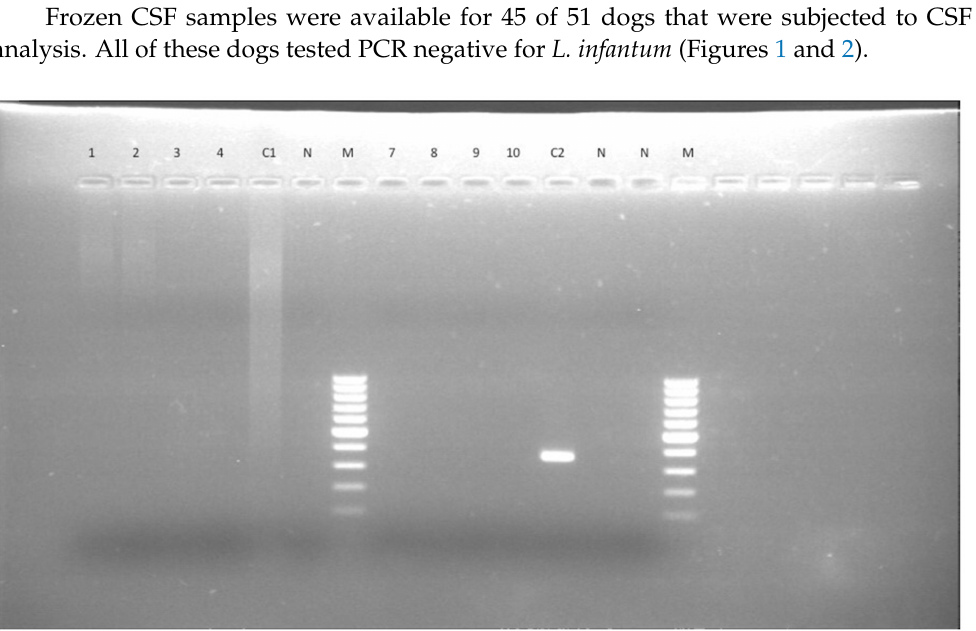
Figure 1. Leishmania genus specific nested-PCR for the diagnosis of L. infantum infection in dogs. cerebrospinal fluid (CSF) negative results: lane 1 to 4, first amplification; lane 7 to 10, second nested amplification. Lane C1 and C2 are positive controls ( L. infantum DNA) for the first and second amplification, respectively. Lane N, negative controls (no DNA). M = molecular size marker (100–1000